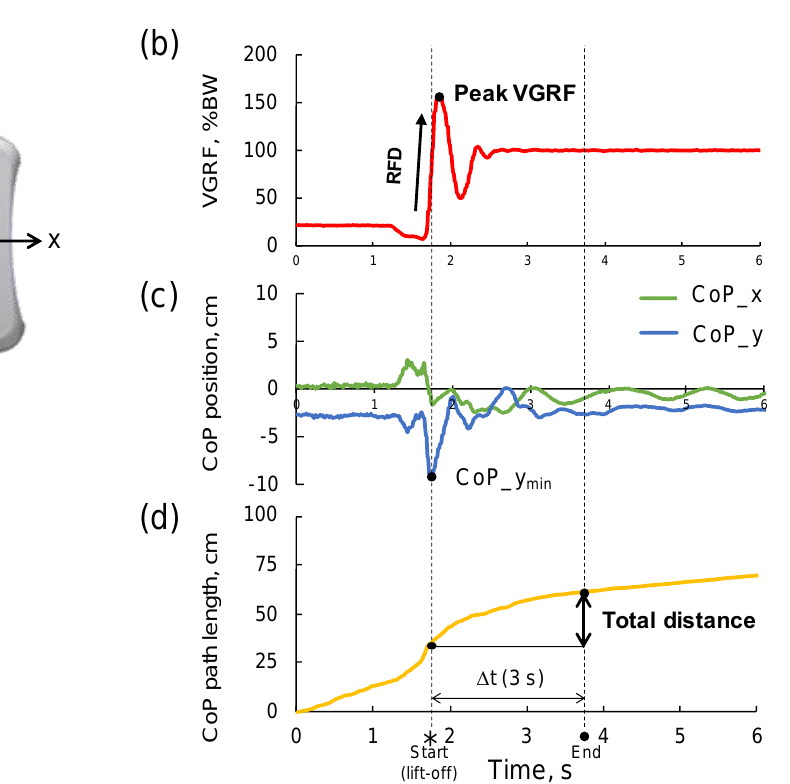
Figure 1. Typical graphs and definitions of the sit-to-stand movement. ( a ) The CoP path is shown with the coordinate system of the Wii Balance Board. The x and y axis are medio-lateral and antero-posterior direction, respectively. The CoP moves from posterior (* indicates start point) to anterior ( • indicates end point). The end point ( • ) indicates the CoP at 3 s after lift-off. The rectangle in blue indicates the CoP sway area (sway area). ( b ) The vertical ground reaction force (VGRF) is normalized by the body weight (%BW). The rate of VGRF (RFD) is defined as an initial slope of the curve. ( c ) The CoP position in the medio-lateral (CoP_x) and antero-posterior (CoP_y) directions are plotted. The CoP_y min is the minimum value of the CoP_y, which indicates a time of lift-off from a chair. ( d ) The CoP path length increases with time. The total distance was calculated as the CoP path length during Δ t .